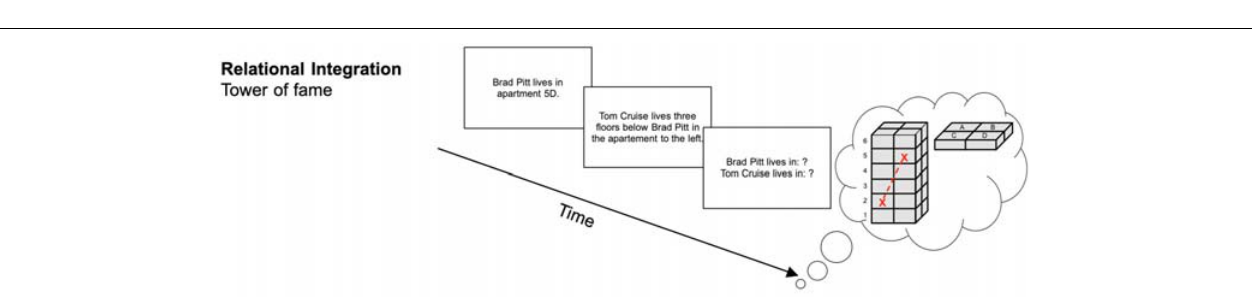
FIGURE 2 | Relational integration task (tower of fame) (reused and adapted with permission from Langer et al., 2013). Participants needed to integrate information into the tower of fame and were then asked about the apartments people lived in Langer et al. (2013); von Bastian et al.